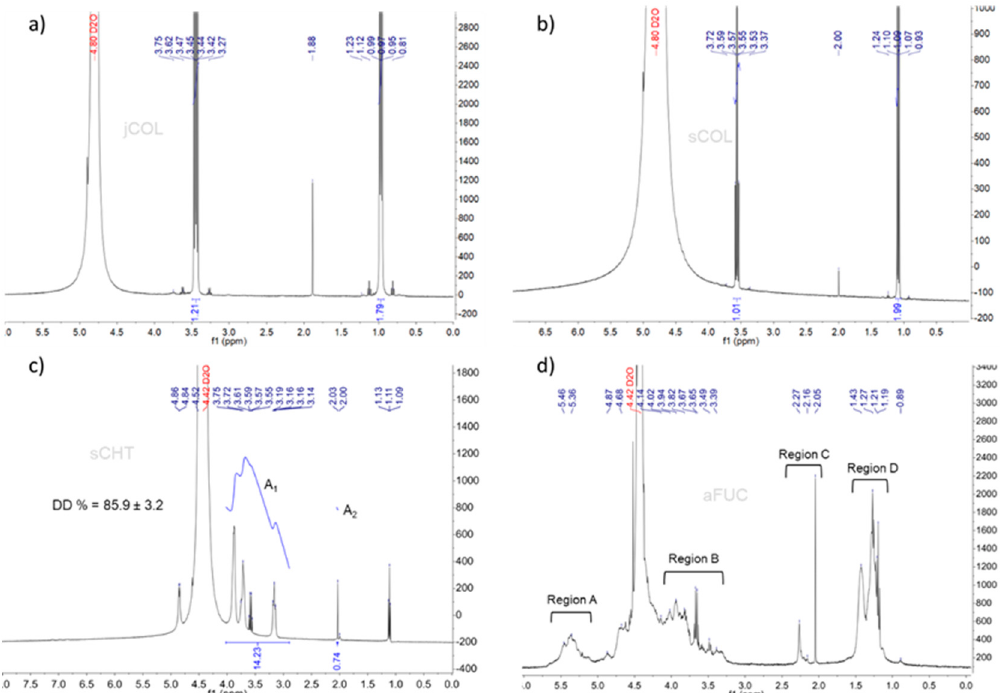
Figure 1. 1 H Nuclear magnetic resonance ( 1 H-NMR) spectra of each marine polymer: ( a ) Collagen from jellyfish (jCOL); ( b ) Collagen from shark (sCOL); ( c ) Chitosan from squid pens (sCHT) and the respective degree of deacetylation (DD) and ( d ) Fucoidan from brown algae (aFUC). The 1 H-NMR of fucoidan (sulfated polysaccharide) is very complex, as